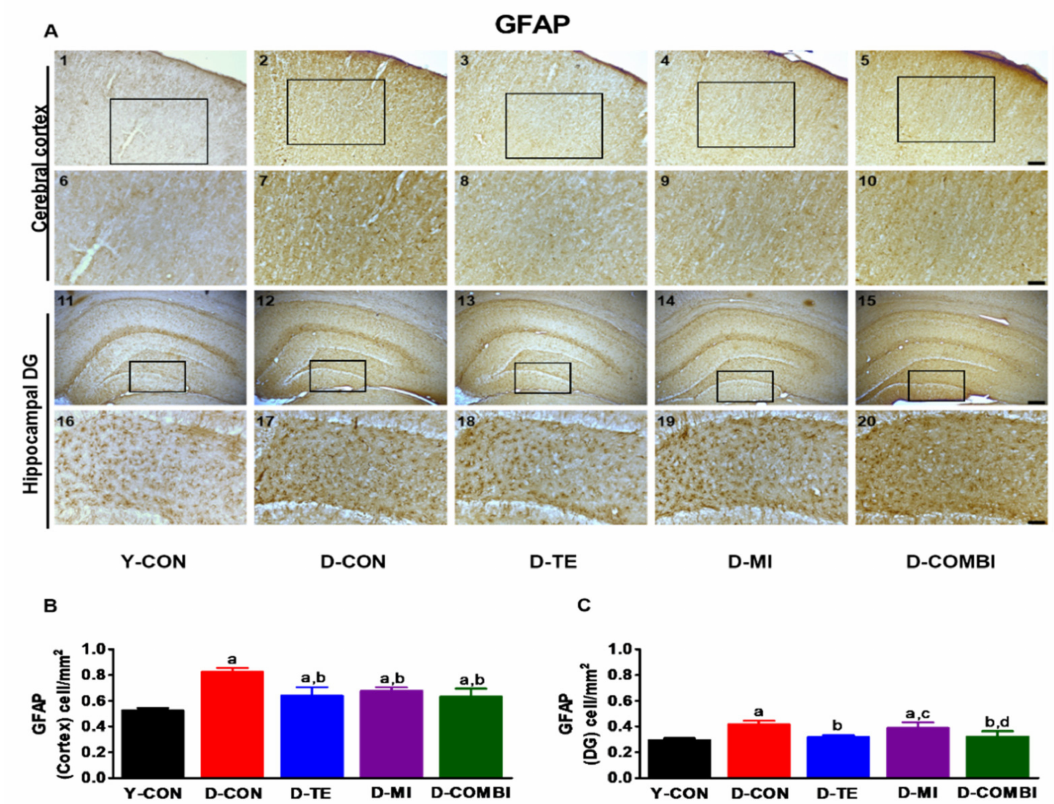
Figure 3. Effects of treadmill exercise and MitoQ on the expression of Glial fibrillary acidic protein (GFAP) in the hip- pocampal dentate gyrus and cerebral cortex of D-galactose-induced aging rats. ( A , 1 – 10 ) Photomicrographs showing GFAP immunoreactivity in the cerebral cortex of D-galactose-induced aging rats in each group. ( A , 11 – 20 ) Photomicrographs showing GFAP immunoreactivity in the hippocampal dentate gyrus of D-galactose-induced aging rats in each group. ( A , 6 – 10 and A , 16 – 20 ) An enlarged view of the area indicated by the black rectangle in A. ( A , 1 – 5 and A , 11 – 15 ) Scale bar = 100 µ m, ( A , 6 – 10 and A , 16 – 20 ) Scale bar = 50 µ m. ( B ) Optical density quantification of GFAP staining in the cerebral cortex. ( C ) Optical density quantification of GFAP staining in the hippocampal dentate gyrus. Bonferroni post hoc test after ANOVA. Values are presented as means ± SD. ( n = 5 animals). a Denotes statistical difference from the Y-CON group. b Denotes statistical difference from the D-CON group. c Denotes statistical difference from the D-TE group. d Denotes statistical difference from the D-MI group ( p <